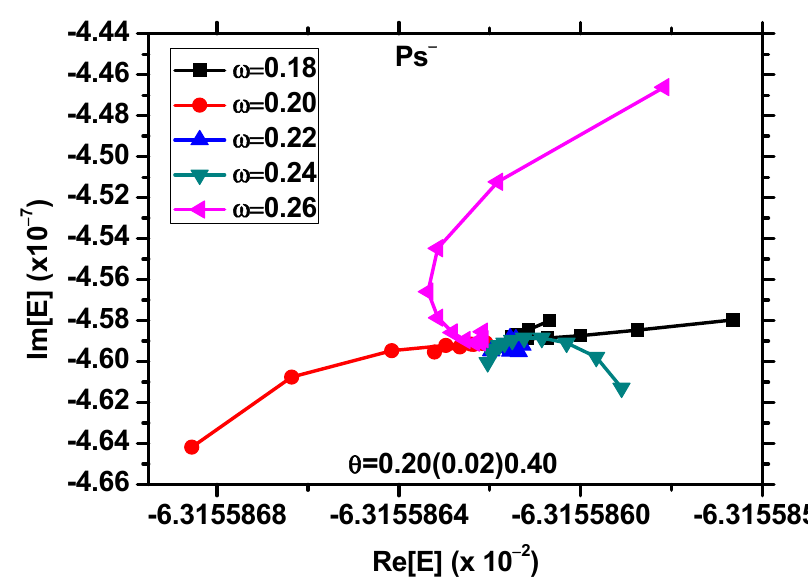
Figure 1. The rotational paths near the pole for the 1 P° (1) FR of Ps − lying below the Ps ( N = 2 ) threshold in the EP for five different values of the scaling parameter ω using 900-term wave ECW.